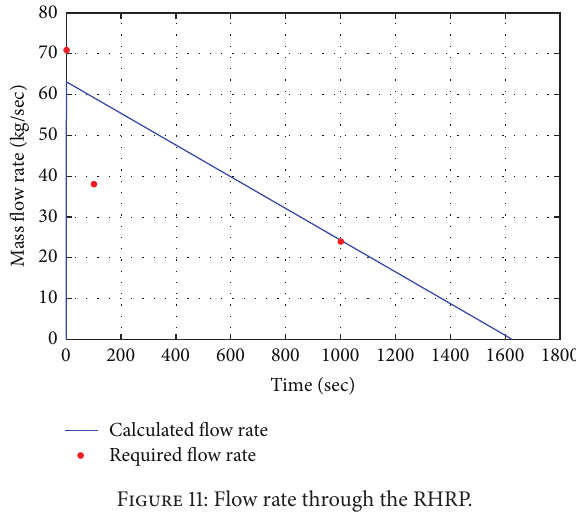
Figure 11: Flow rate through the RHRP.